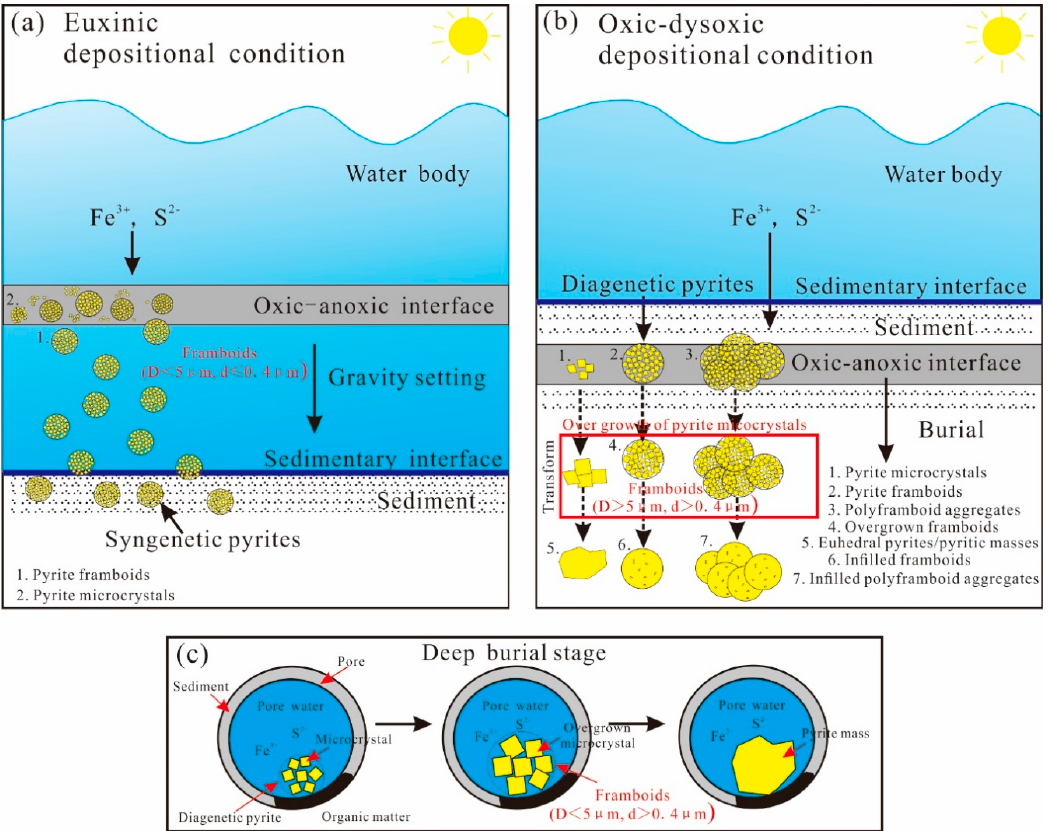
Figure 1. ( a ) Formation mechanism of syngenetic pyrites under the euxinic depositional conditions; ( b ) formation mechanism of early diagenetic pyrites under the oxic-dysoxic depositional conditions [22]; ( c ) formation mechanism of late diagenetic pyrites in the deep burial stage.